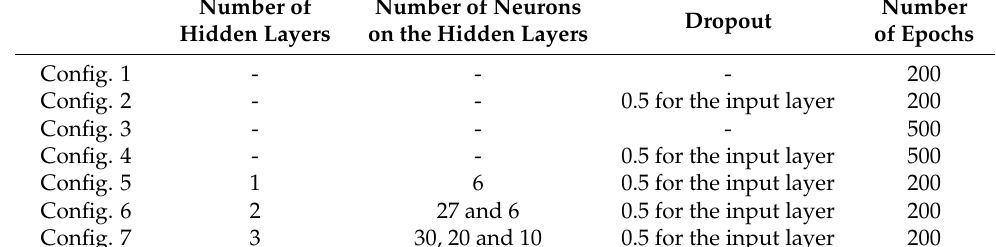
Table 12. Tested configurations for the overlapping dataset.